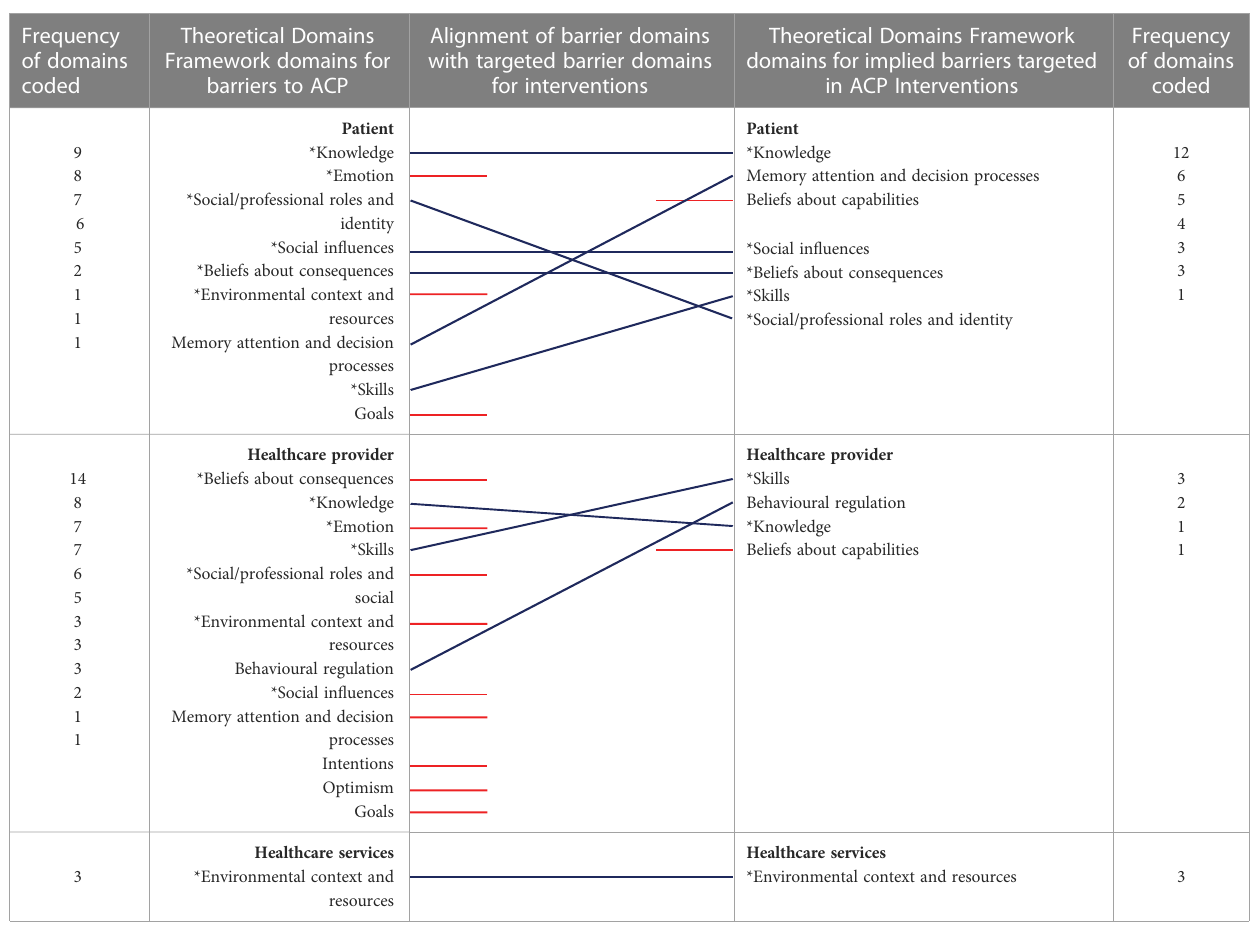
TABLE 5 Frequencies of the Theoretical Domains Framework domains for barriers of ACP and barriers targeted by ACP